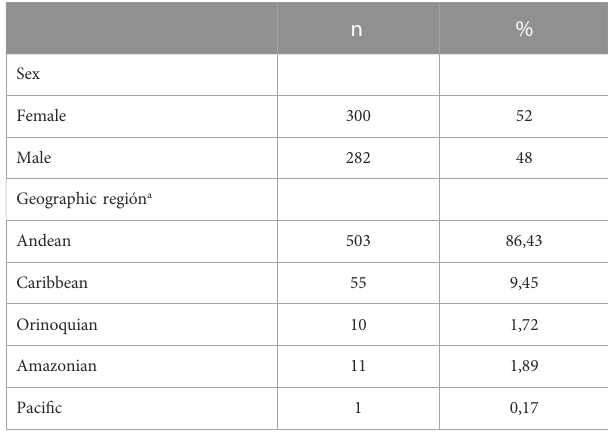
TABLE 2 Demographic